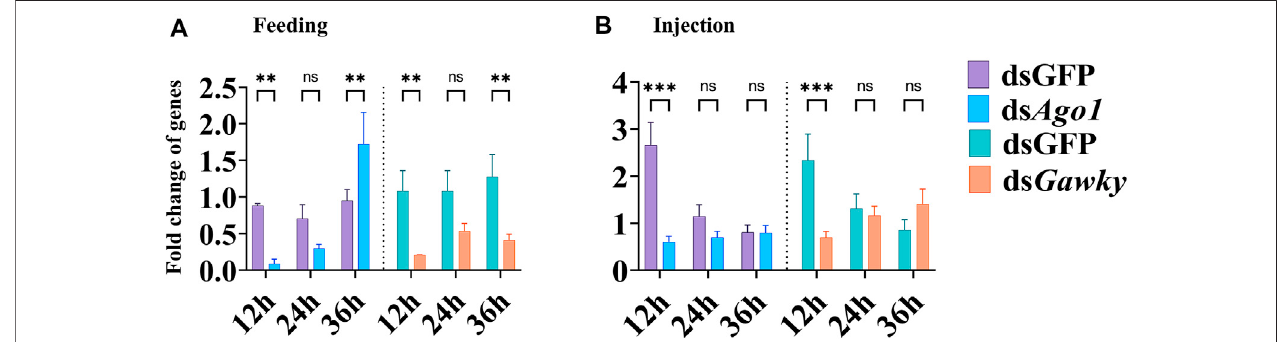
FIGURE3| Changesintheexpressionof Ago1 and Gawky afterdsRNAtreatmentbyfeedingorinjection.Thevaluesoftherelativeexpressionlevelof Ago1 and Gawky fromthetreatmentwerecalculatedwiththosefromthecontrolgroupfedandinjectedwithdsGFP. (A) Expressionpatternof Ago1 and Gawky afterfeedingoftheir dsRNAs. (B) Expressionpatternof Ago1 and Gawky after injection oftheir dsRNAs.The barsrepresent 2 – ΔΔ CT values(±SD) normalizedtothe geometrical meanofthe expressionof two housekeeping genes. The asterisks above the bars designate signi fi cant differences (* p < 0.05; ** p < 0.01; *** p ≤ 0.001, ns: not signi fi